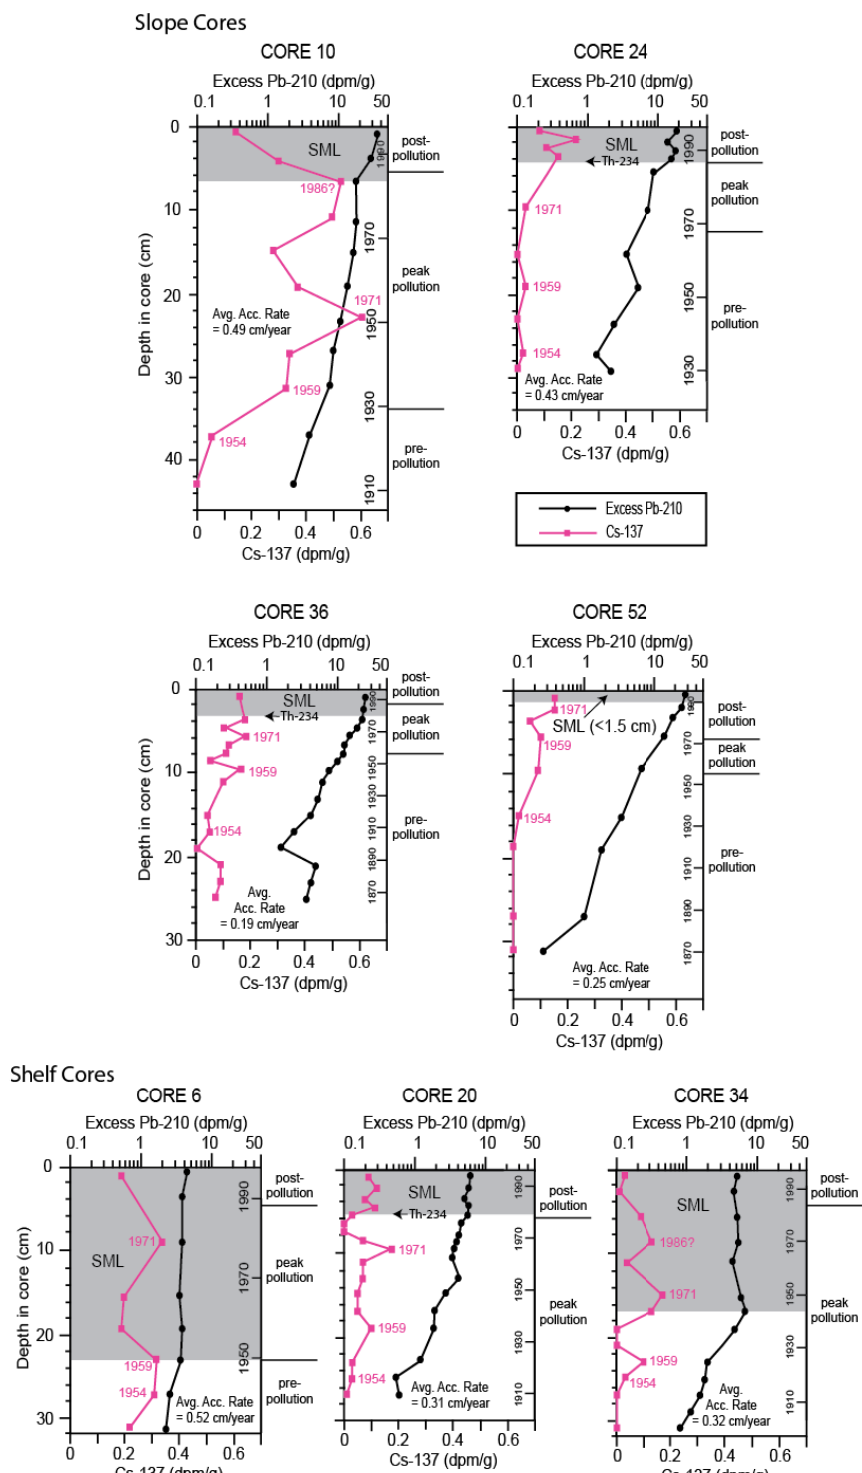
Figure 3. Radiochemical profiles of excess Pb-210 (black) and Cs-137 (pink) for seven cores from Santa Monica Bay. Approximate calendar ages (on right) calculated for each core using the average sediment accretion rates based on the Pb-210 profiles. Cs-137 peaks are labeled and penetration depths of excess Th-234 shown by arrows. Surface Mixed Layer (SML) highlighted in gray. Estimated ranges of pre-pollution, peak pollution, and post-pollution periods identified. Radiochemical data courtesy of Clark Alexander and Claudia Venherm (Skidaway Institute of